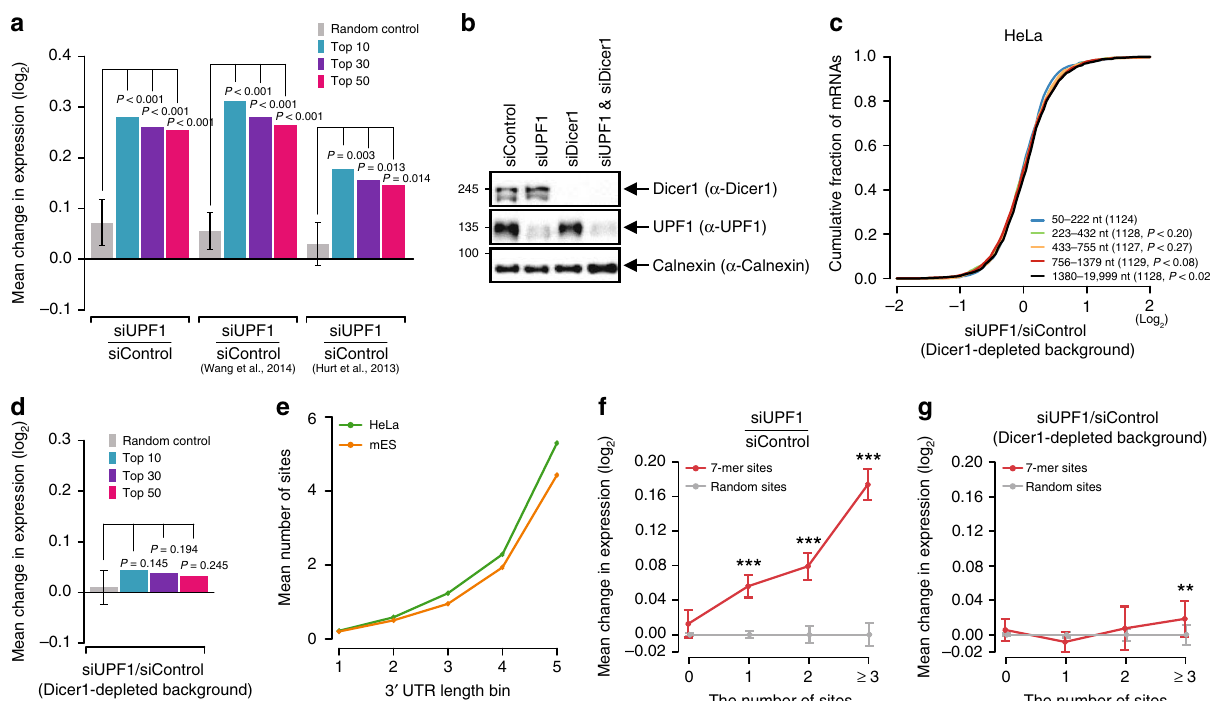
Fig. 3 UMD regulation requires miRNAs. a The mean changes in expression (log 2 scale) of dEJ-free mRNAs embedding 7-mer target sites of random controls (gray), the 10 (blue), 30 (purple), and 50 (red) most abundant miRNA families under siUPF1-treated conditions are shown. The P value was calculated by comparing the mean change in the expression of the targets to those in the 1000 random control cohorts (see “ Generation of random controls and statistical tests ” ) using a one sample t test. The same analyses were performed for our data (left), Wang et al. 2014 ’ s data (middle), and Hurt et al. ’ s data (right). The error bars indicate the s.e.m. in the changes for the targets. b HeLa cells were transfected with siUPF1, siDicer1, or both siUPF1 and siDicer1. The downregulation of endogenous UPF1 and/or Dicer1 was con fi rmed by western blotting. Calnexin served as a loading control. c CDF graphs of changes in the expression of dEJ-free mRNAs between siUPF-treated and siControl-treated cells under Dicer1-depleted conditions are shown across different 3 ′ UTR length bins. Otherwise, as in Fig. 1b – d. d Mean changes in the expression of dEJ-free mRNAs with 7-mer target sites between siUPF-treated and siControl-treated cells under Dicer1-depleted conditions. Otherwise, as in a . e Mean numbers of 7-mer miRNA target sites in the 3 ′ UTRs of dEJ-free mRNAs are shown across different 3 ′ UTR length bins. The sites were detected in the major 3 ′ UTR isoform, as evident by our previous 3P-seq data pro fi led from HeLa (green) and mES (orange) cells 11 . f Mean changes in expression of dEJ-free mRNAs in siUPF1-treated cells against siControl-treated cells are shown across the different 7-mer site numbers of the ten most abundant miRNA families (red) and different random 7-mer sites (gray). Asterisks denote groups whose number of sites is signi fi cantly different from that of the controls ( *** P < 0.001; K – S test). g Mean changes in expression between dEJ-free mRNAs of siUPF-treated and siControl-treated cells under Dicer1-depleted conditions are shown for the different 7-mer site numbers. Otherwise, as in